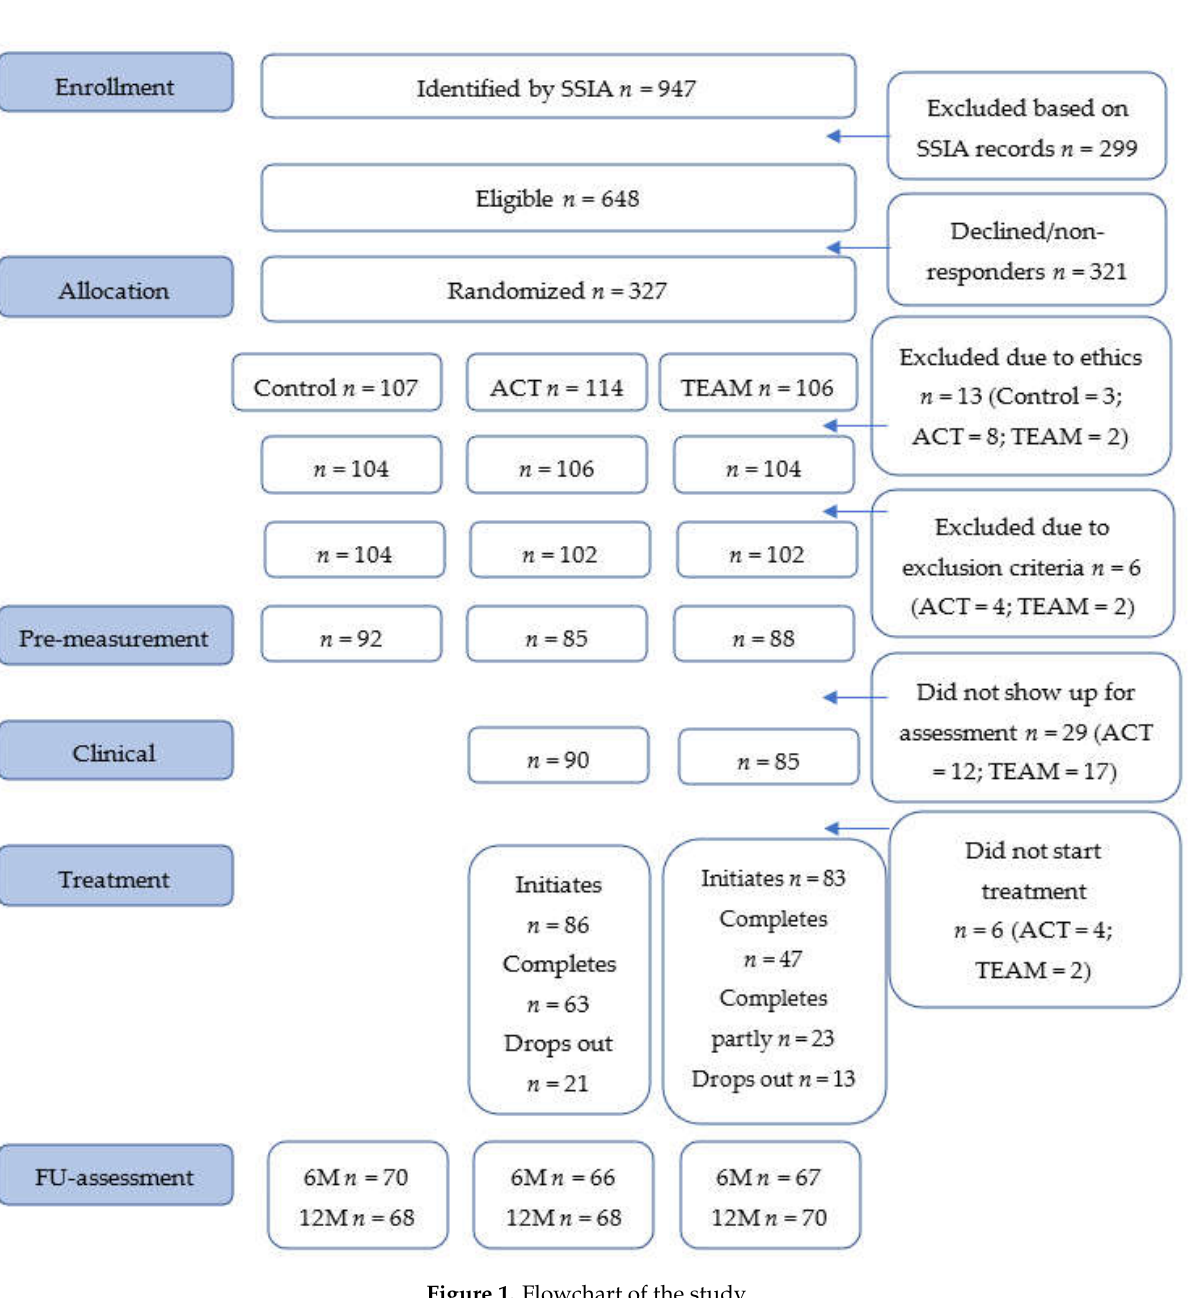
Figure 1. Flowchart of the study.